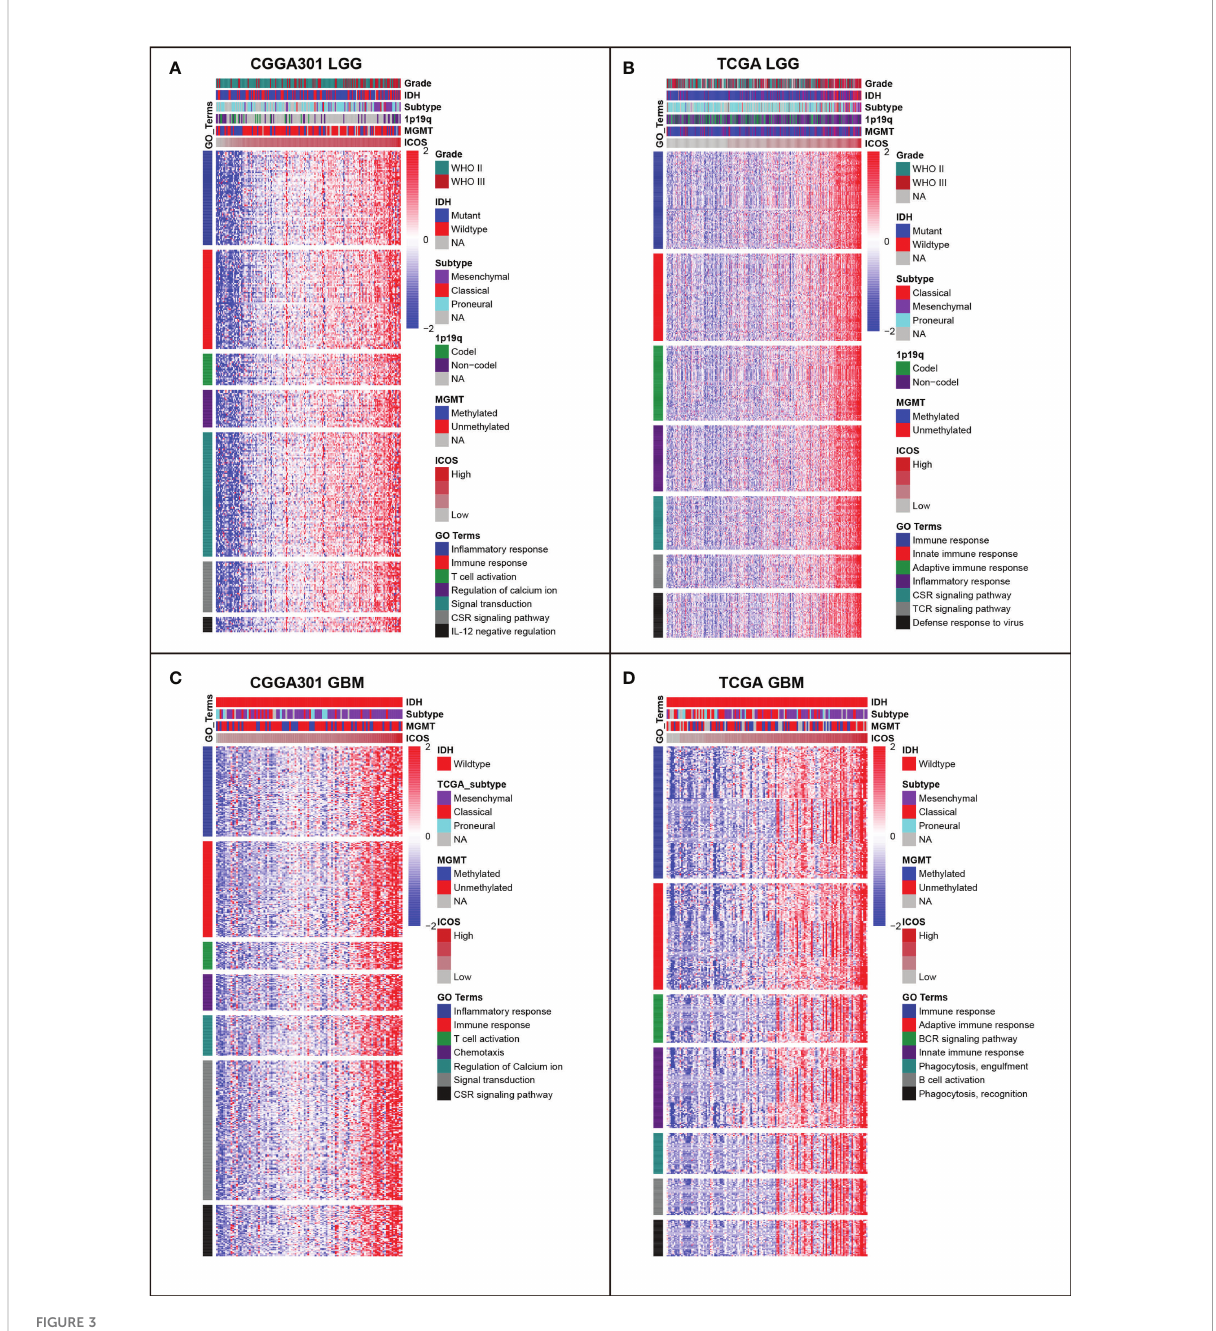
FIGURE 3 Gene ontology (GO) of genes associated with ICOS in CGGA301 and TCGA datasets. (A) GO in CGGA301 lower-grade glioma. (B) GO in TCGA lower-grade glioma. (C) GO in CGGA301 glioblastoma. (D) GO in TCGA